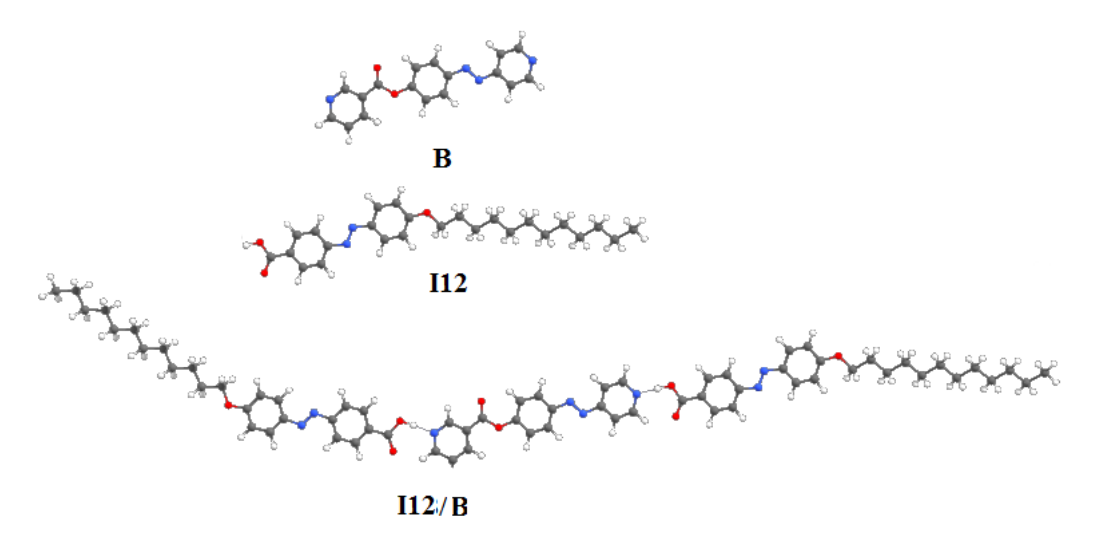
Figure 6. Comparison between the present SMHB In/B complexes (●) and five-ring IIn/B system ( ○ ) in nematic stability.